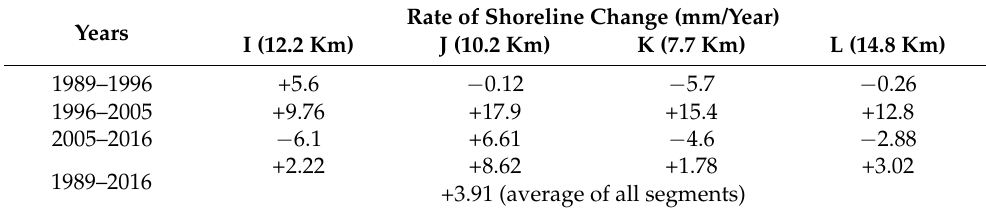
Figure 11. Shoreline change rates along Cox’s Bazar for the periods of 1989–1996 (red), 1996–2005 (green), and 2005–2016 (blue). Negative values indicate erosion (landward movement of shoreline). Table 3. Rates of shoreline changes for the different segments of Cox’s Bazar in the study period of 1989 – 2016.